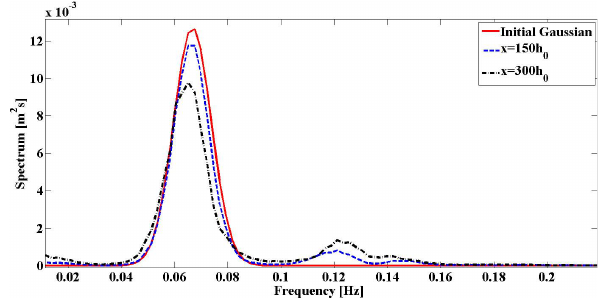
Fig. 1. Power spectra of surface elevation at x = 150 h 0 and at x = 300 h 0 for Ur =0.4. Red solid line corresponds to the initial Gaussian shaped spectrum. Constant depth h 0 = 10m.